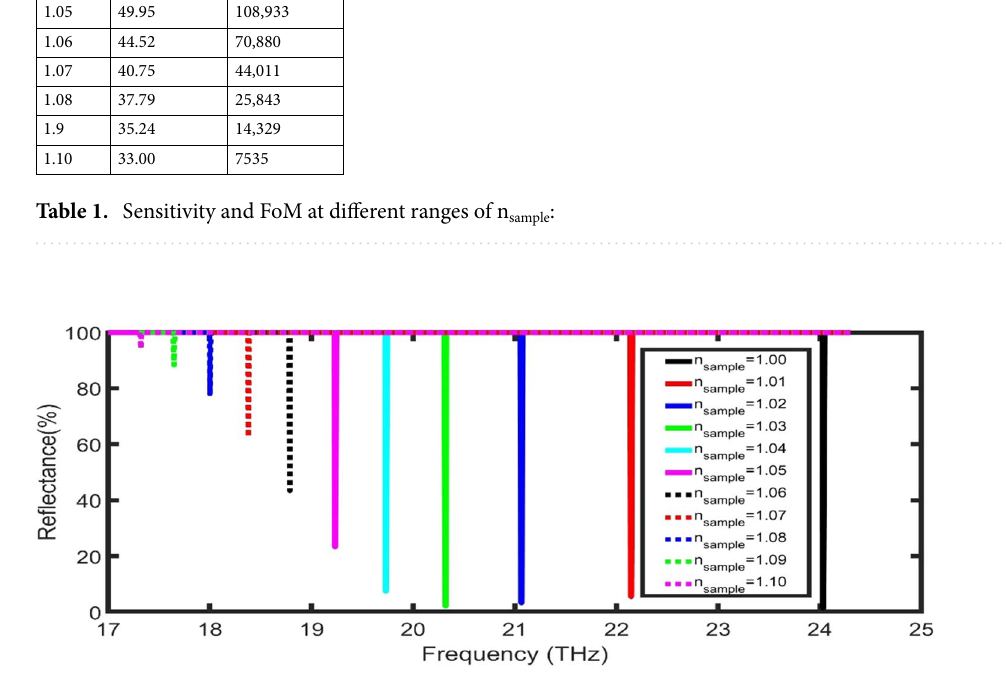
Figure 6. The reflectance spectra of the proposed sensor at different values of refractive indices.